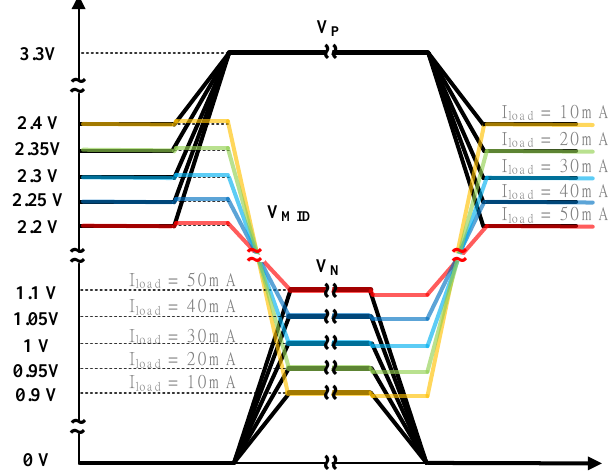
Figure 5. Power transistor gate voltage waveforms depending on the amount of load current.